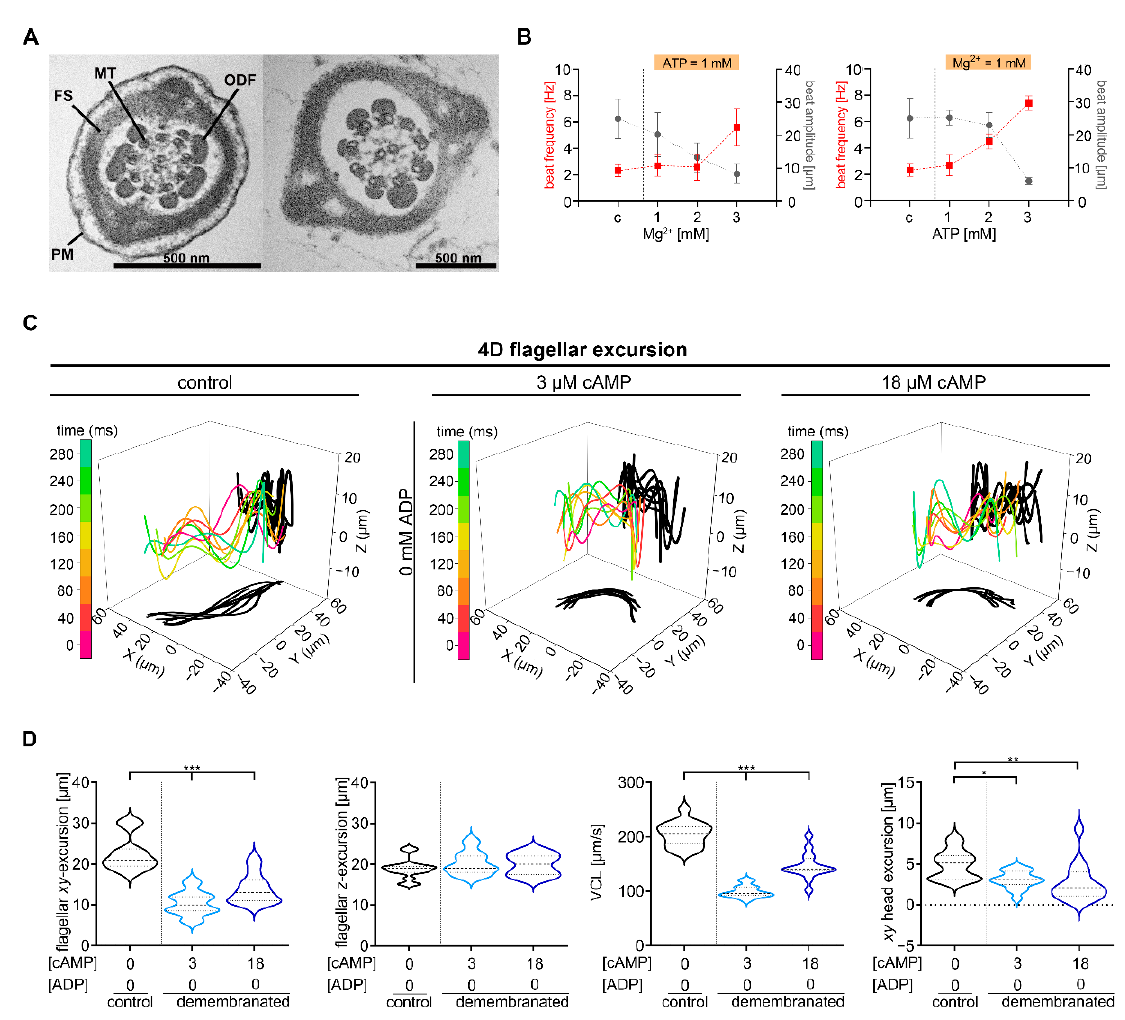
Figure 1. 4D motility of demembranated wt sperm. ( A ) Representative transmission electron mi- croscopy cross sections of flagella mid-pieces of membranated (left) and demembranated (right) sperm. MT—microtubules, FS—fiber sheath, PM—plasma membrane, ODF—outer dense fiber. Scale bar = 500 nm. ( B ) Analysis of beat frequency and beat amplitude of demembranated mouse sperm with 1 mM ATP and different Mg 2+ concentrations (1–3 mM) (left) or with 1 mM Mg 2+ and differ- ent ATP concentrations (1–3 mM) (right). An increase in ATP or Mg 2+ concentration results in an increase in beat frequency and a decrease in the beat amplitude compared to membrane intact control sperm (c). mean ± SEM; N = 4, n = 12. ( C ) 4D waveform analysis of intact sperm (first panel) com- pared with demembranated sperm analyzed without ADP but with increasing cAMP concentrations (0, 3, 18 µ M). Traces of a flagellum in 3D at different time points (0, 40, . . . , 280 ms) are color-coded and the projections onto the XY -and XZ -plane are shadowed in black. ( D ) Statistical analysis of XY -(first panel) and Z -excursions of flagella (second panel), 3D curvilinear velocity (VCL) (third panel) and lateral head displacement (forth panel) of intact and demembranated sperm in the pres- ence of different cAMP and ADP concentrations (color-coded). N = 4, n = 15, * p < 0.05, ** p < 0.01, *** p < 0.001, median: thick dashed lines; interquartile range: thin dashed